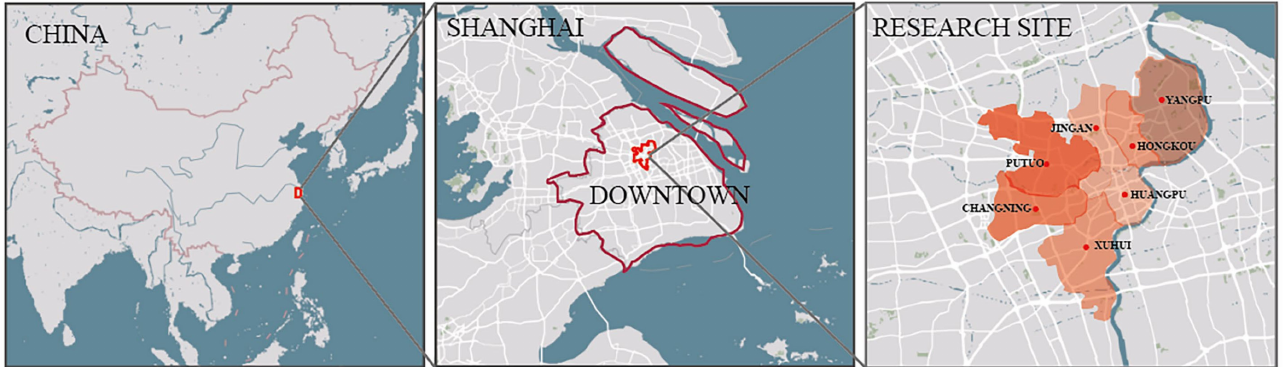
Figure 2. Research site (administrative boundary of